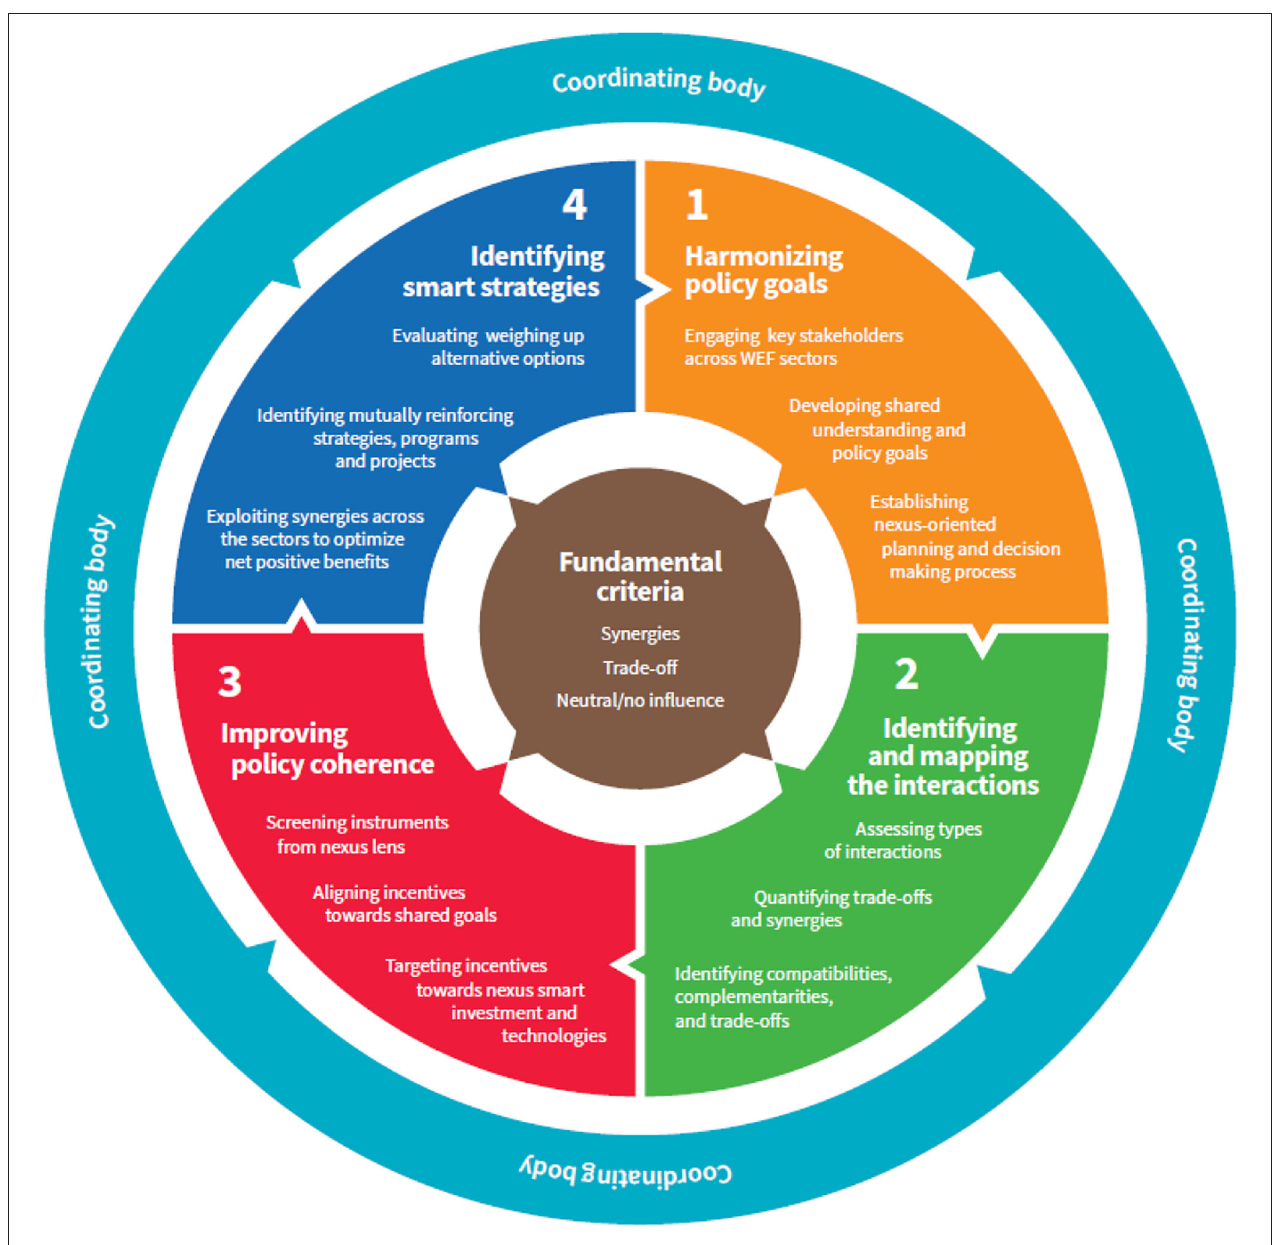
FIGURE 1 | Generic framework for operationalization of a food-water-energy nexus